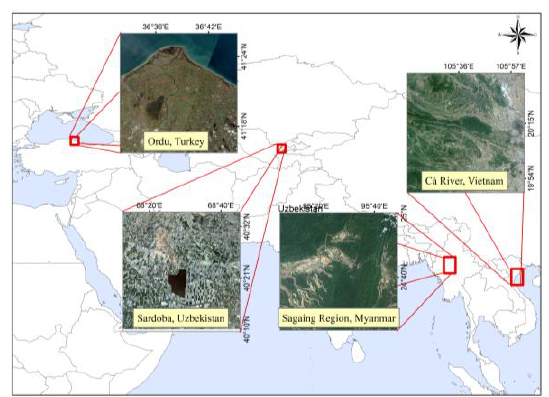
Figure 2 . The location map of the study sites.